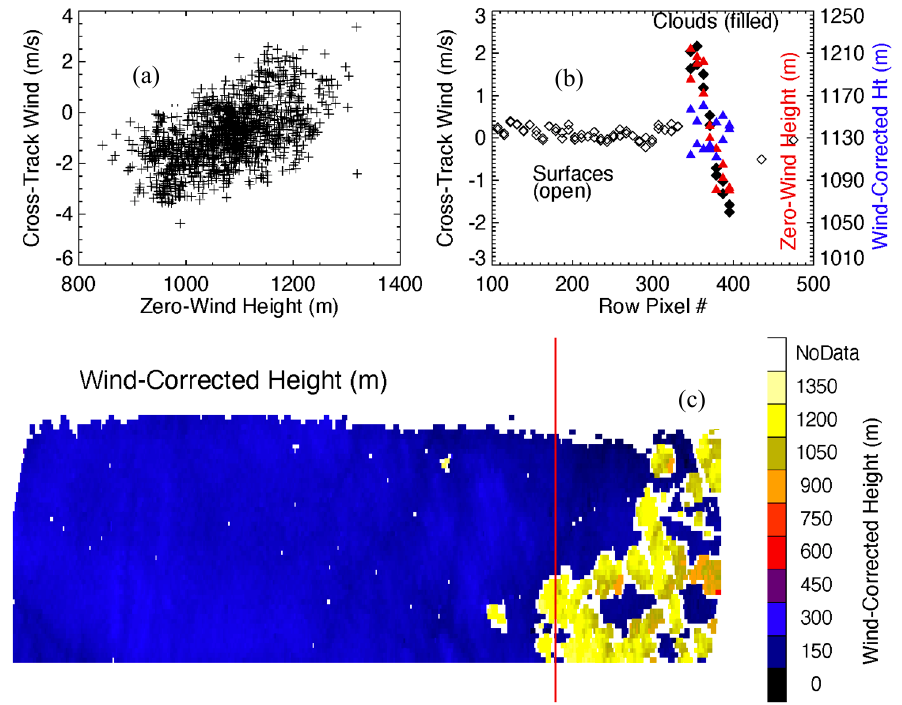
Figure 12. Analysis of Hold F2 for ( a ) scatter plot of XT wind vs. zero-wind height; ( b ) XT winds and heights as a function of row pixel #; and ( c ) wind-corrected height. The red line is a transect along which the data in ( b ) are plotted. The open and closed diamonds depict XT winds for surface pixels and cloudy pixels, respectively. For cases in which the pixels are cloudy, the red and blue triangles depict zero-wind heights and wind-corrected heights. When the AT winds are assumed to be zero (i.e., zero wind), an anomalous correlation between XT winds and zero-wind heights appears. When more realistic AT winds are assumed as described below, the correlation largely disappears.